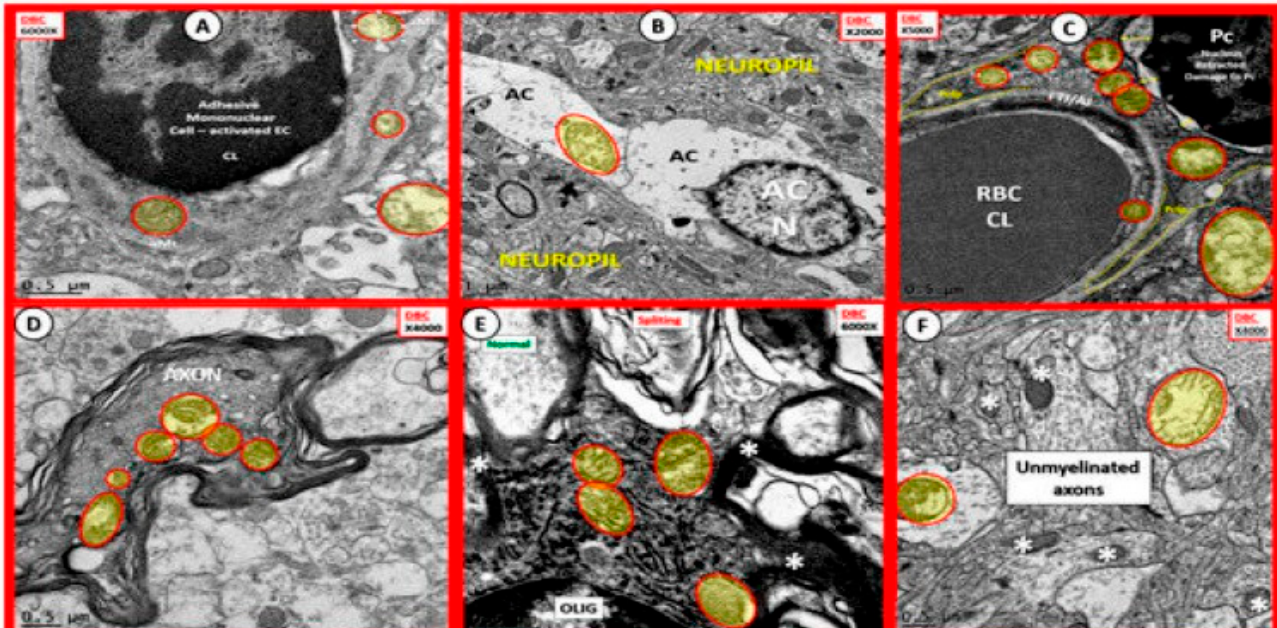
Figure 8. Aberrant Mitochondria in Brain Endothelial cells (EC), Astrocytes (AC), Pericytes (Pc), Myelinated and Unmyelinated Neurons and Oligodendrocytes (OLIG) in the Diabetic db/db Models. The aberrant mitochondria (aMt) are pseudo-colored yellow with red outlines in order to allow for rapid identification. Panels ( A – F ) demonstrate aberrant mitochondria (aMt) in each of the brain cells depicted. Panel ( A ) depicts aMt in ECs and adjacent AC foot processes. Panel ( B ) depicts an aMt within the cytoplasm of an AC. Panel ( C ) depicts multiple aMt in the cytoplasm of a Pc. Panel ( D ) depicts aMt within a myelinated neuronal axon that also demonstrates separation of its lining myelin sheath. Panel ( E ) depicts aMt in an oligodendrocyte’s cytoplasm. Panel ( F ) depicts aMt with the axoplasm of an unmyelinated neuronal axon. Note that most of the aMt are hypolucent as a result of the loss of their normal electron dense matrix proteins and they share a common feature of attenuated and or loss of their crista; they are also enlarged. Magnifications are located in the upper part of each panel and the scale bars are at the bottom. The images in this figure were modified with permission by CC 4.0 [27].